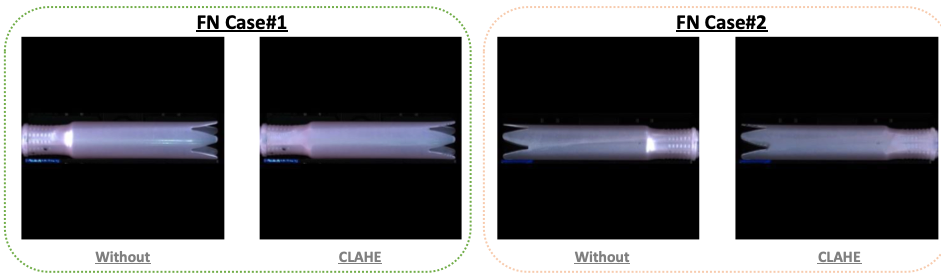
Figure 23. Two FN cases detected by